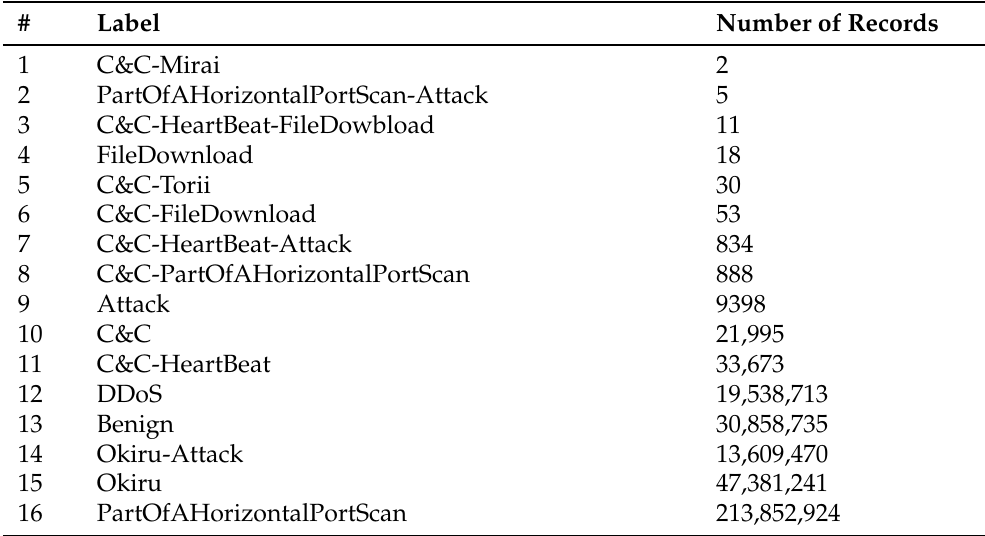
Table 3. The IoT-23 dataset record distribution.